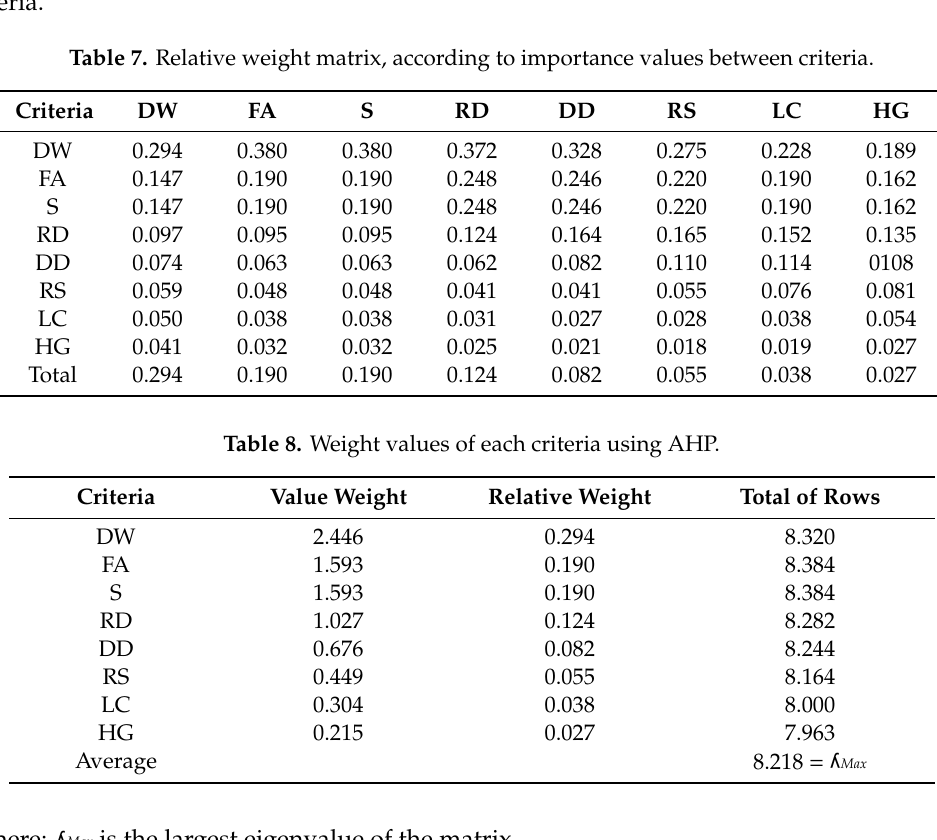
Table 8. Weight values of each criteria using AHP.